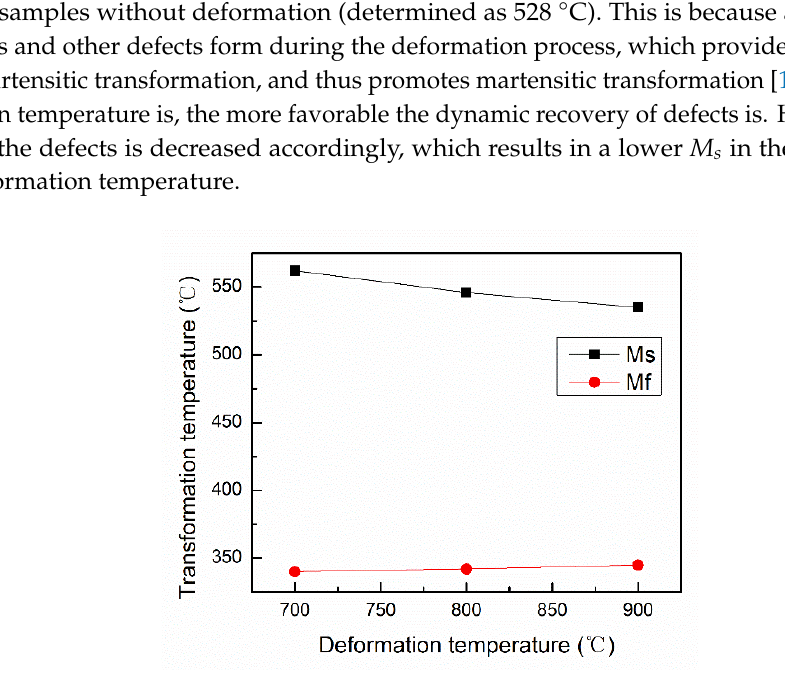
Figure 8. Phase transformation temperatures for the low-carbon ferritic stainless steel samples deformed at the different temperatures.